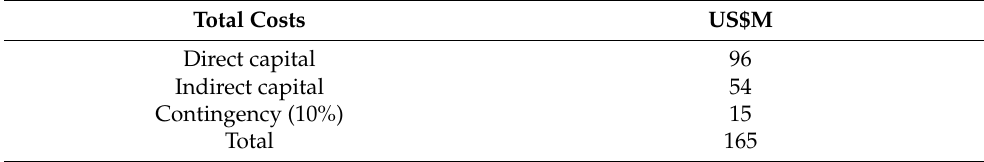
Table 6. Total CAPEX values of the company Neometals. Source: [35].